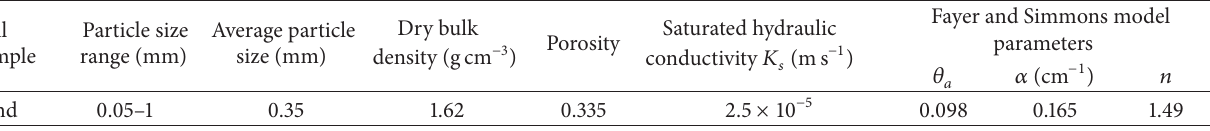
Table 1: Selected properties of sand